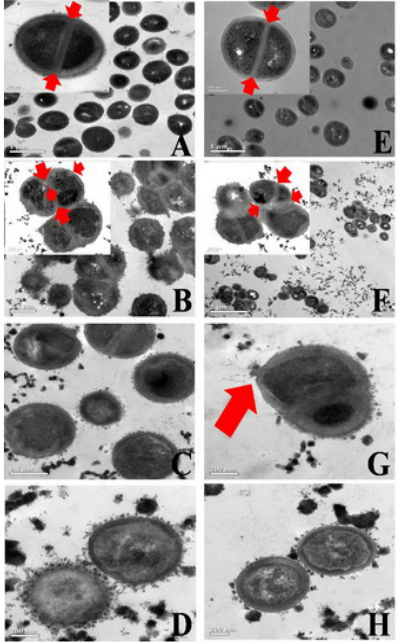
Figure 3. Transmission electron micrographs of S. aureus ATCC 25923 ( A–D ) and the M09 MRSA strain ( E–H ) 12 h after treatment with different concentrations of MSKE, 1 MIC ( B, F ) 2 MICs ( C, G ) and 4 MICs ( D, H ), when compared to the control, 1% DMSO, ( A, E